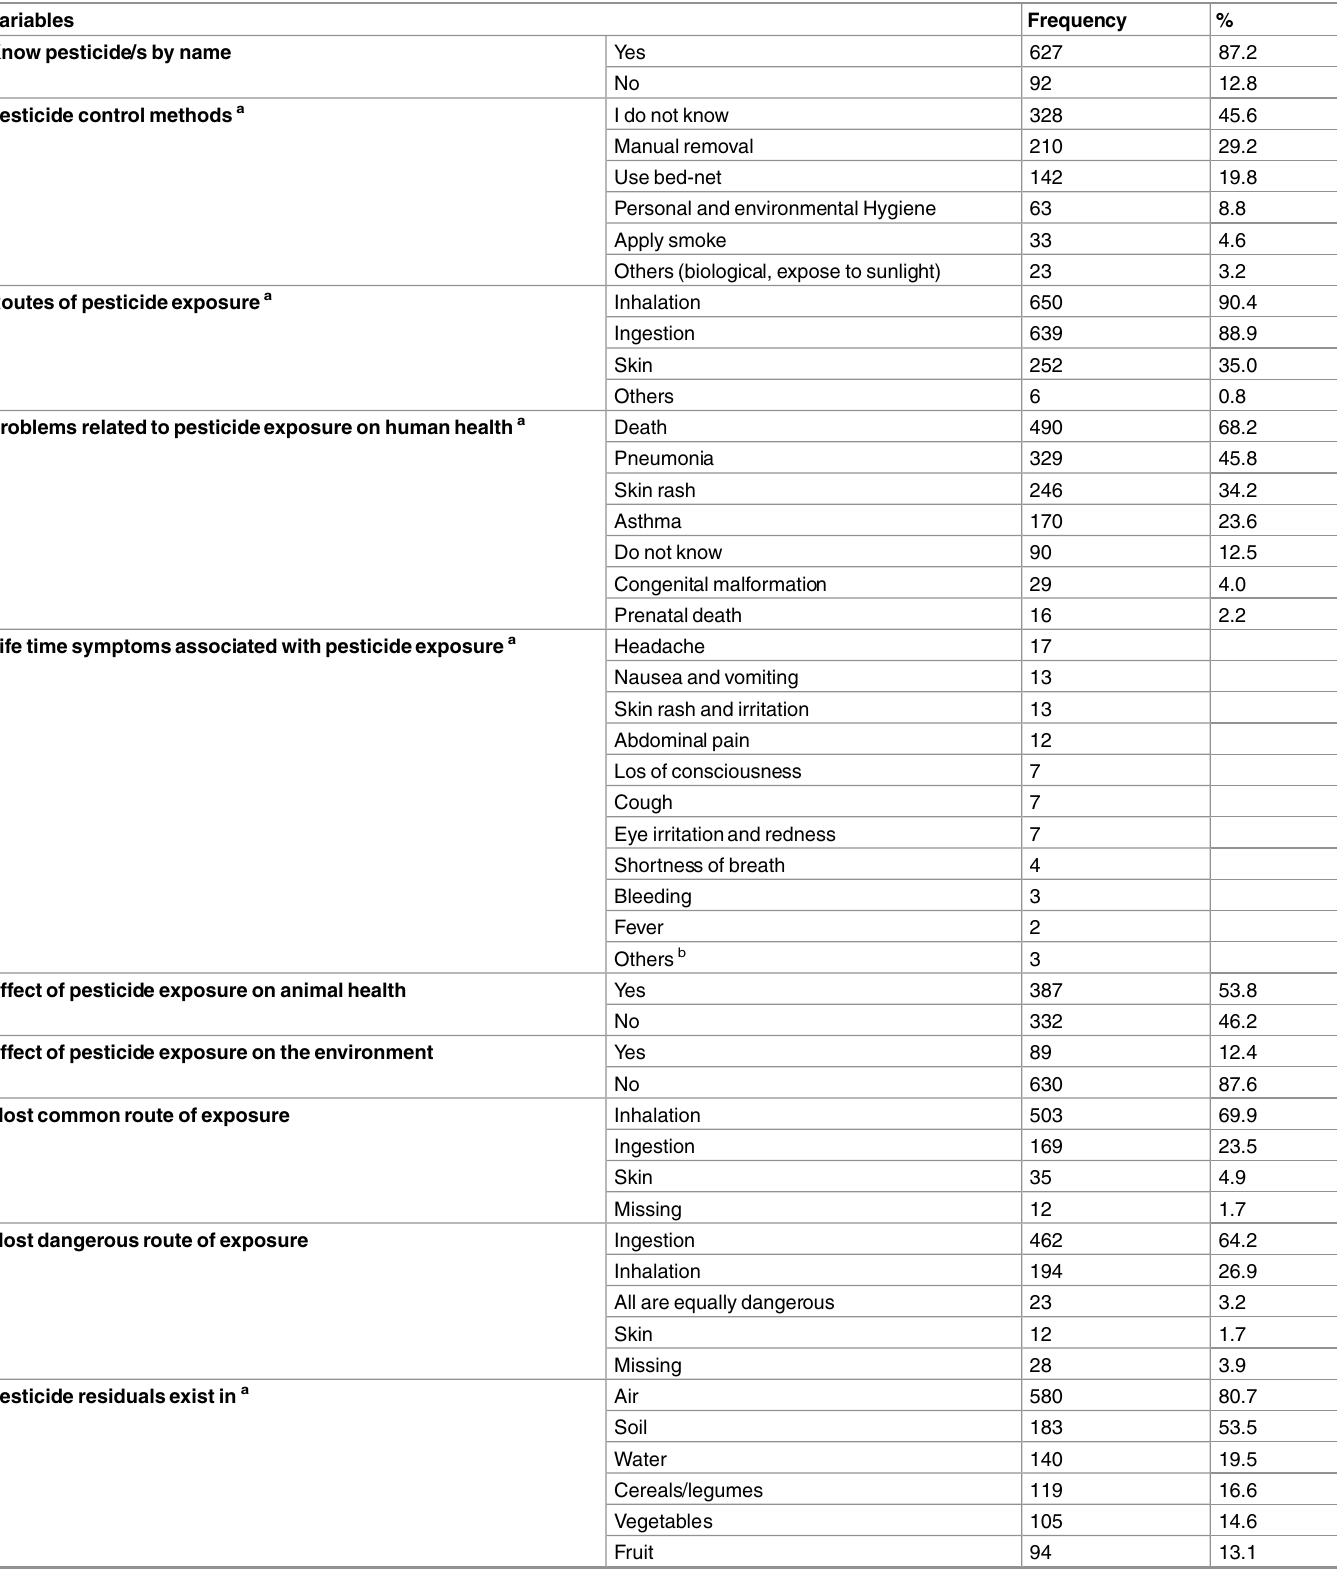
Table 2. Knowledge of farmers towards safe use of